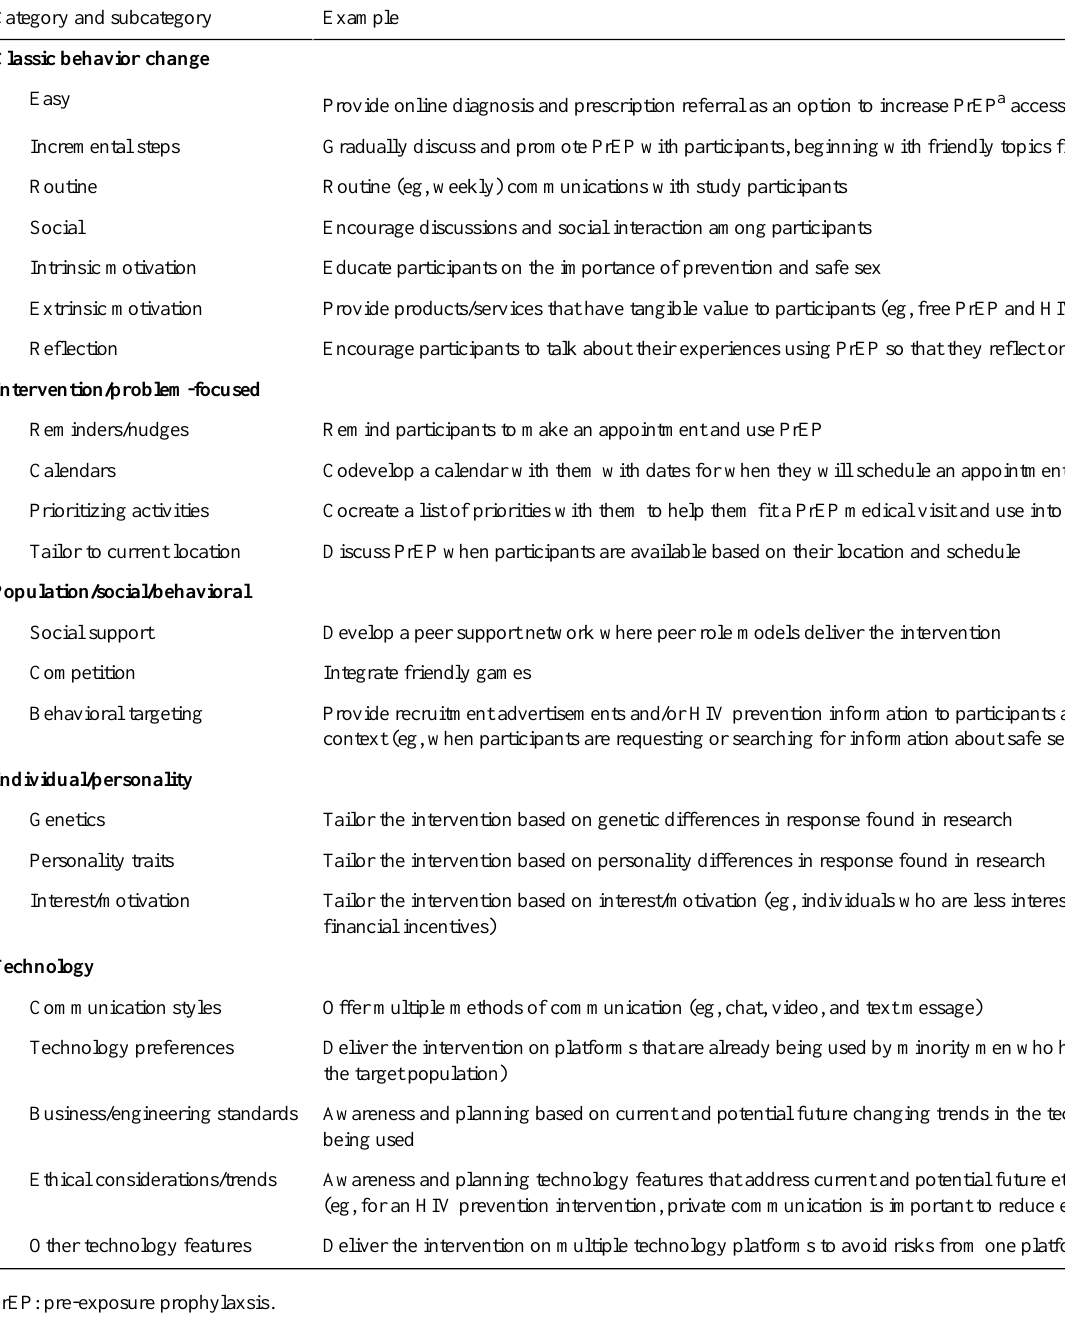
Table 1. Applying the Adaptive Behavioral Components (ABC) model for technology-based interventions. This table provides an example of how a researcher might apply the ABC framework in an intervention designed to increase uptake of pre-exposure prophylaxis among African American and Latino men who have sex with men at risk for HIV. The examples below are not exhaustive but are meant to assist readers in understanding how to integrate ABC into intervention